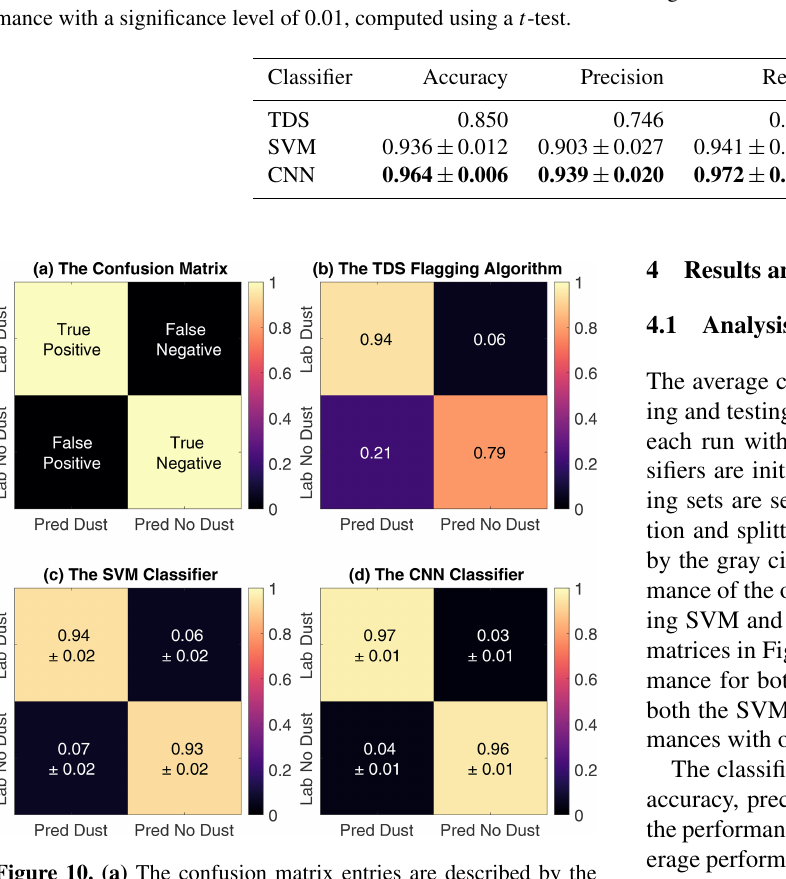
Figure 10. (a) The confusion matrix entries are described by the true (correctly classified) and false (erroneously classified) values; compared to the manual labels (Lab), positive indicates dust pre- dictions (Pred), and negative indicates no dust predictions. (b) The TDS classifier confuses dust and no dust observations, where a sig- nificant proportion ( > 0 . 20) of dust predictions are manually la- beled as no dust . (c) The SVM classifier predicts both dust and no dust observations with a high ( > 0 . 90) accuracy. (d) The CNN clas- sifier predicts a very large ( > 0 . 95) proportion of both dust and no dust observations